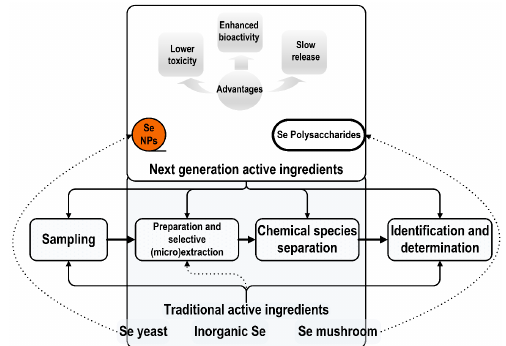
Figure 4. Schematic representation of the analytical procedures for determining and characterizing selenium in dietary supplements. The analysis of the next-generation selenium dietary supplements